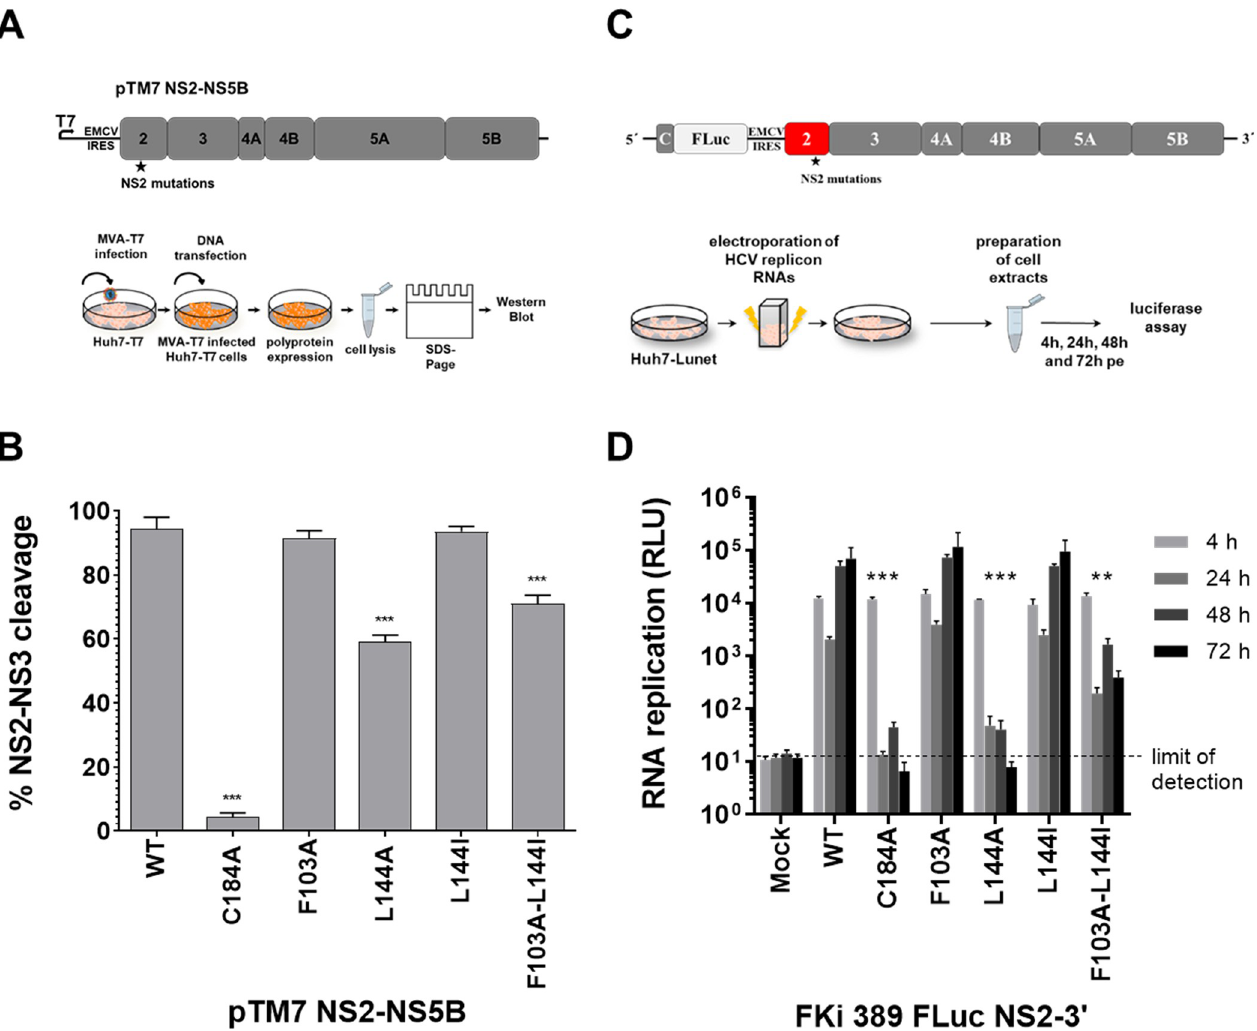
Fig 8. The NS2 F103A/L144I double mutation is reducing NS2-NS3 cleavage efficiencies in the NS2-NS5B context and is reducing robust RNA replication of a NS2-5B JFH1 replicon. (A, upper panel) Scheme of pTM7-NS2-NS5B/JFH1. (A, lower panel) schematic of the NS2-NS3 cleavage assay. 6 μ g of the indicated pTM7-NS2-NS5B/JFH1 plasmids were transfected into MVA/T7 pol -infected Huh7-T7 cells. Lysates were analyzed by SDS/PAGE-Western blotting using HCV anti-NS2 and anti-NS3 antibodies, respectively. (B) Quantification of the NS2-NS3 cleavage. Western blot signals of NS2, NS3 and uncleaved NS2-NS3 of three independent Western blots were quantified by ImageJ software and the percentage of NS2-NS3 cleavage (% NS2-NS3 cleavage) was calculated. Mean and standard deviations of NS2-NS3 cleavage efficiencies are presented. (C, upper panel) Experimental setup for RNA replication assay. Huh7 Lunet cells were electroporated with 10 μ g of respective FKi-389_FLuc-NS2-3’/JFH1 RNAs. Lower panel, determination of viral replication. HCV RNA replication kinetics were quantified at 4, 24, 48 and 72 h post electroporation by measuring firefly luciferase activity (relative light units, RLU). Graphs are representative results of three independent experiments with standard deviations. WT: wild-type; mock: electroporation control without RNA. Asterisks indicate statistically significant differences in comparison to WT ( � p < 0.05; �� p < 0.01; ��� p <